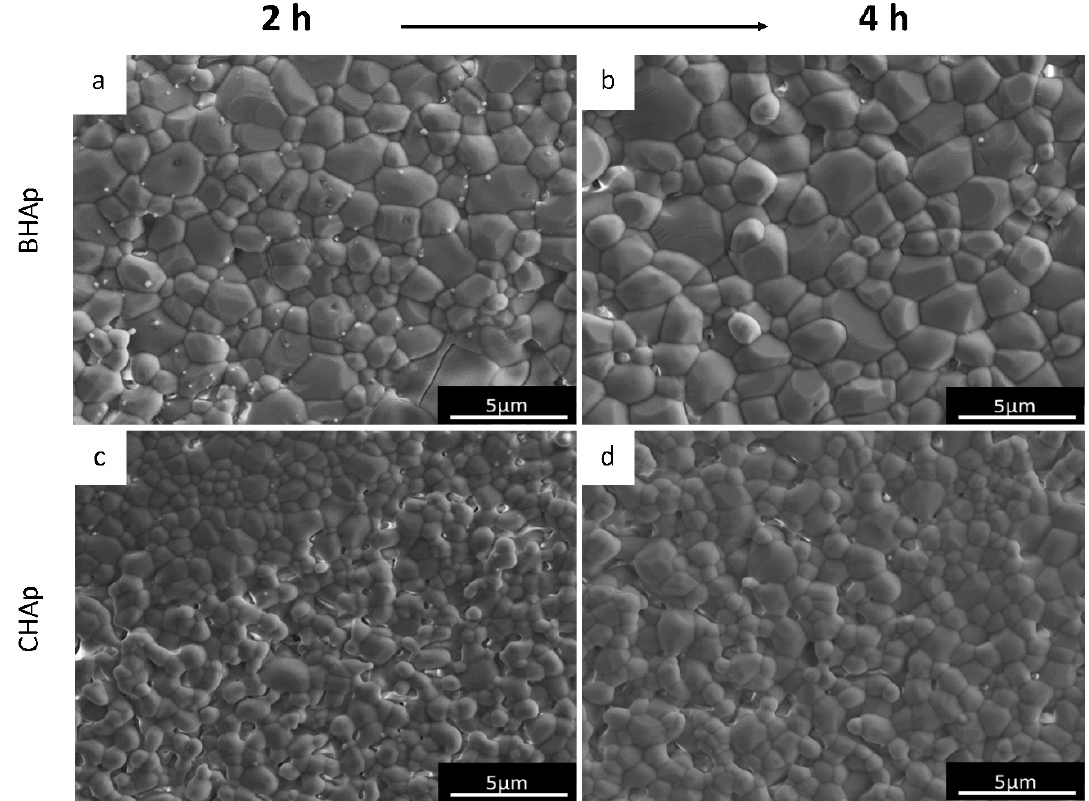
Figure 2. SEM micrographs of sintered ceramics after: 2 h ( a , c ); and 4 h ( b , d ).